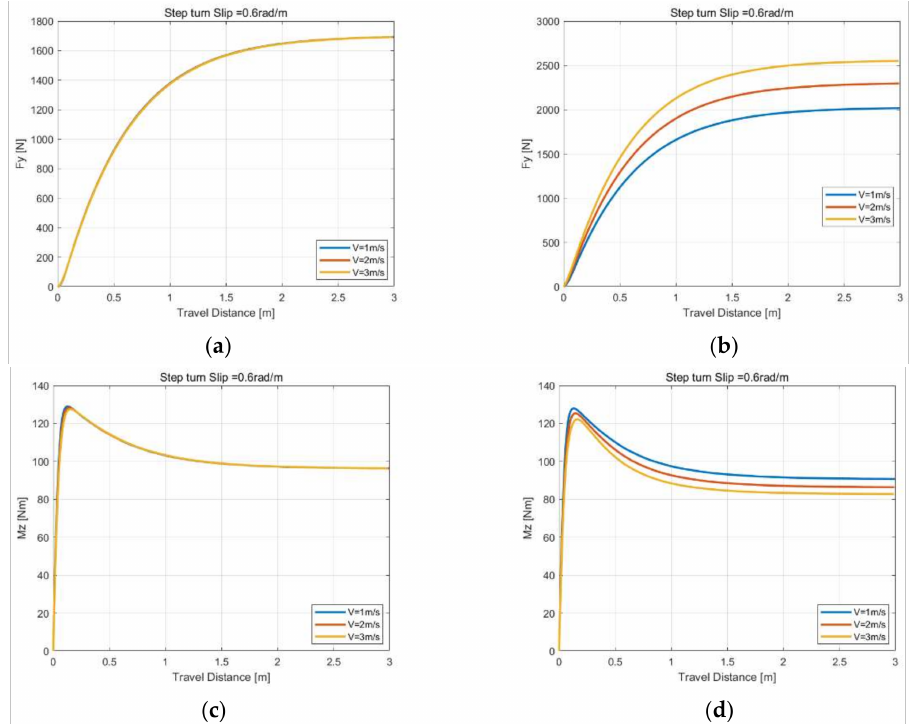
Figure 15. Response of the lateral force and aligning moment under step turn slip input. ( a ) Response of lateral force using the proposed method. ( b ) Response of lateral force using the reference method. ( c ) Response of aligning moment using the proposed method. ( d ) Response of aligning moment using the reference method.